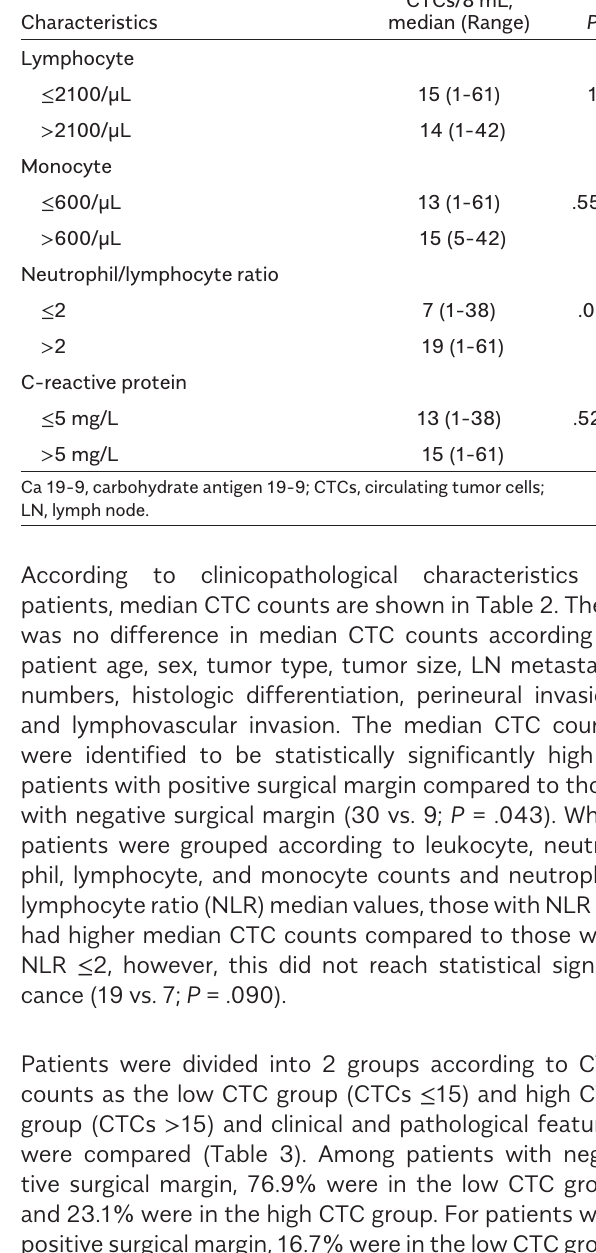
Table 2. The Median Number of CTCs According to Clinicopathological Characteristics of Patients